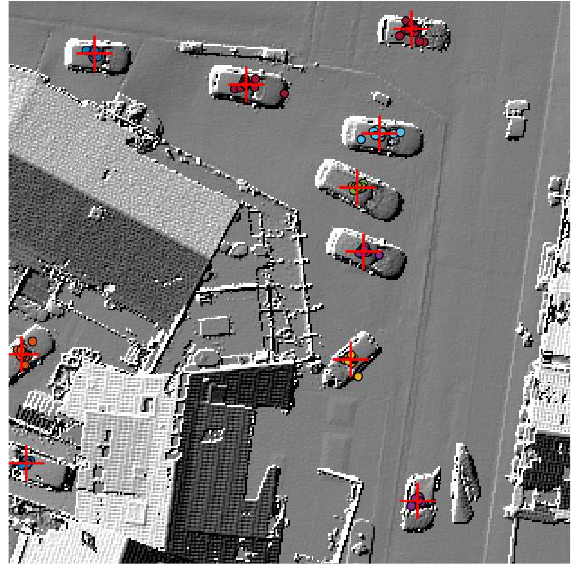
Figure 6. Result of integration for an exemplary subset of